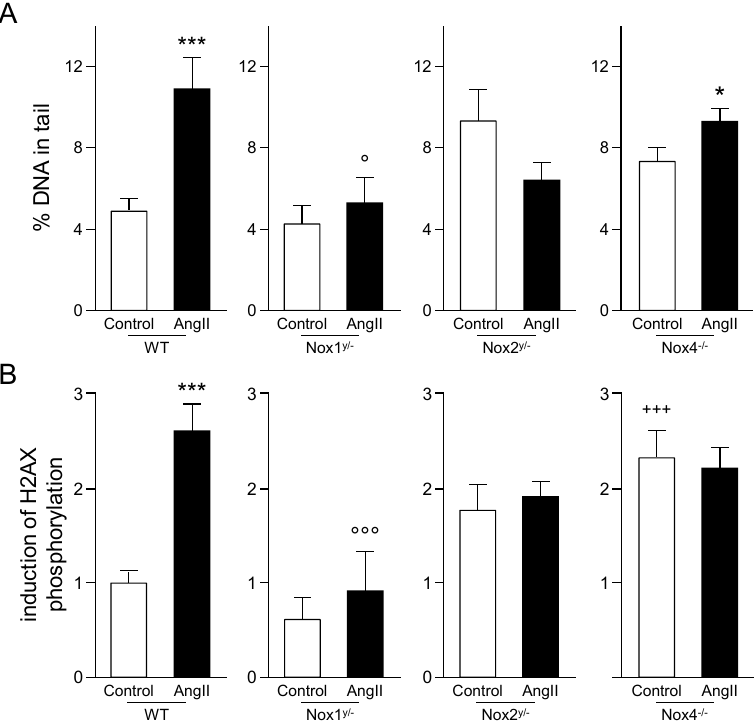
Figure 5. DNA damage caused by angiotensin II. ( A ) DNA damage measured by the comet assay in kidney cells extracted from kidneys at the end of the experiment. Results are shown as percentage of DNA in tail + SEM; ( B ) Quantification of cells positive for phosphorylated H2AX ( γ -H2AX) in the cortex of the kidney within eight visual fields after immunohistochemical detection of γ -H2AX on paraffin-embedded or frozen kidney sections with the help of the cell image analysis software CellProfiler [20]. Results are shown as induction of H2AX phosphorylation + SEM. * p ≤ 0.05, *** p < 0.001, vs. the respective control animals analyzed by the Student’s t -test; +++ p < 0.001 (F(1.50) = 9.64) vs. WT control animals; and ° p ≤ 0.05 (F(1.45) = 5.74, °°° p < 0.001 (F(1.49) = 13.89) vs. angiotensin II-treated WT animals, analyzed by two-way ANOVA.